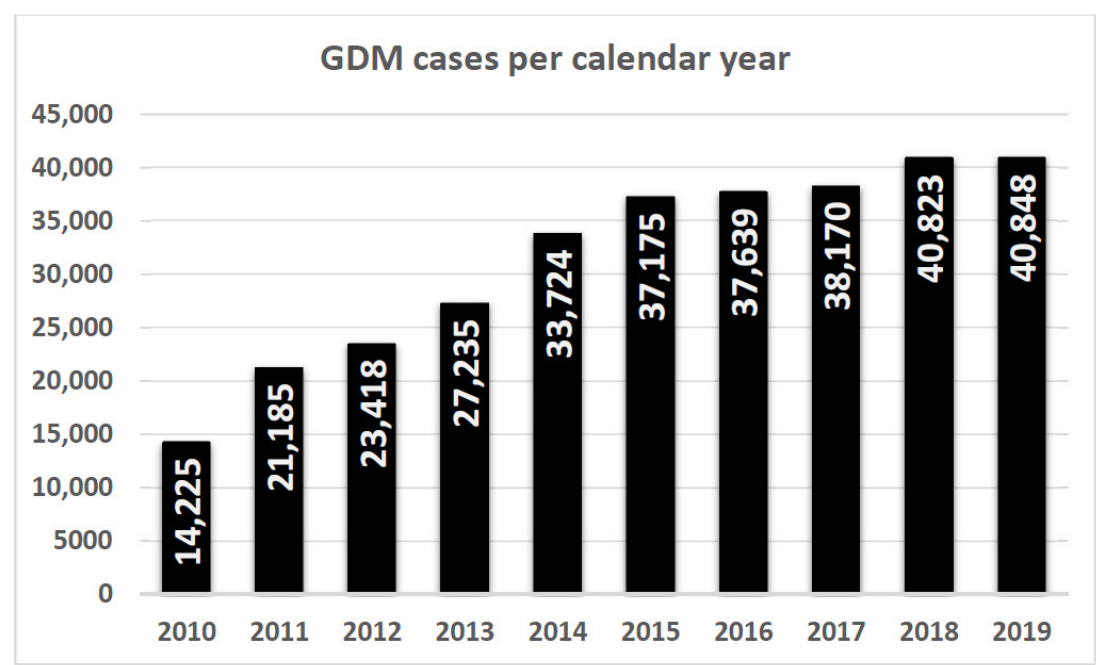
Figure 1. The number of women diagnosed with GDM in Australia per year (National Diabetes Service Scheme—NDSS) pre- and post-2015 IADPSG guideline implementation. Solid vertical columns refer to total GDM diagnoses enrolled with NDSS per annum.